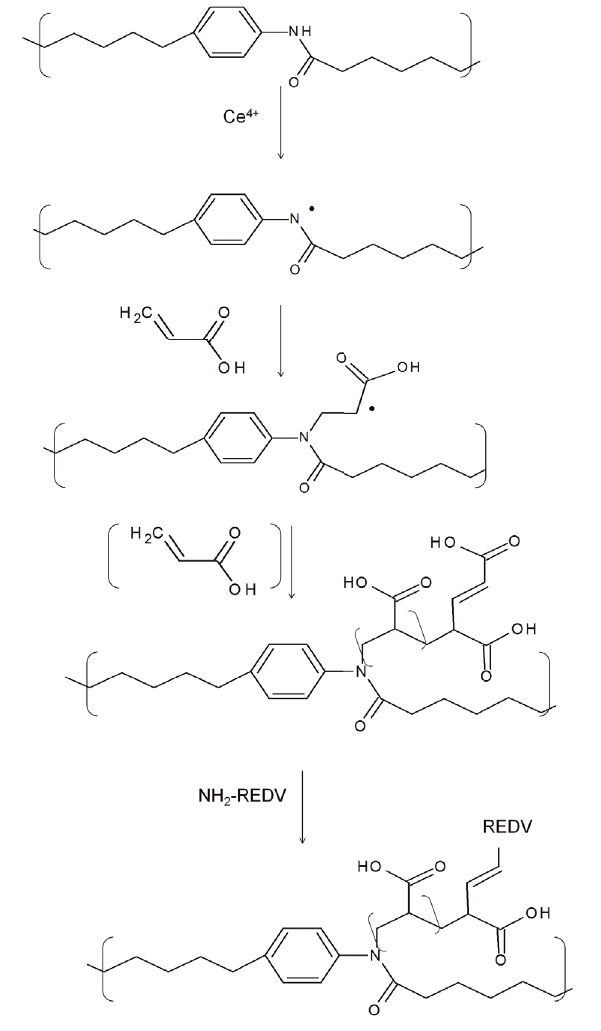
Figure 1 : Scheme of the mechanism of acrylic acid (AA) graft ing to polyurethane (PU) followed by coupling of peptide molecules